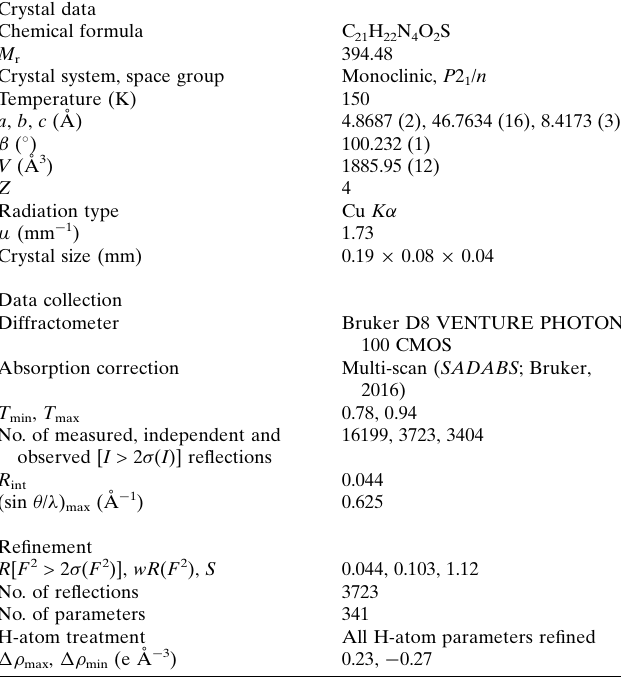
Table 2 Experimental details.